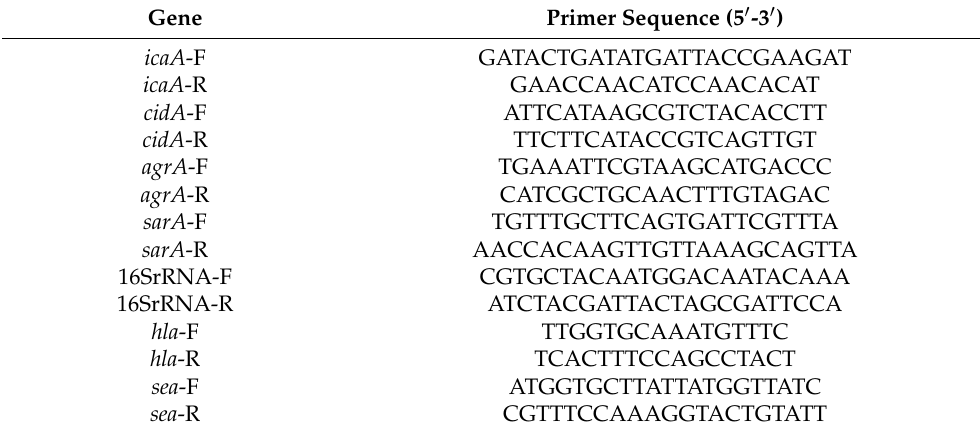
Table 1. Primers for